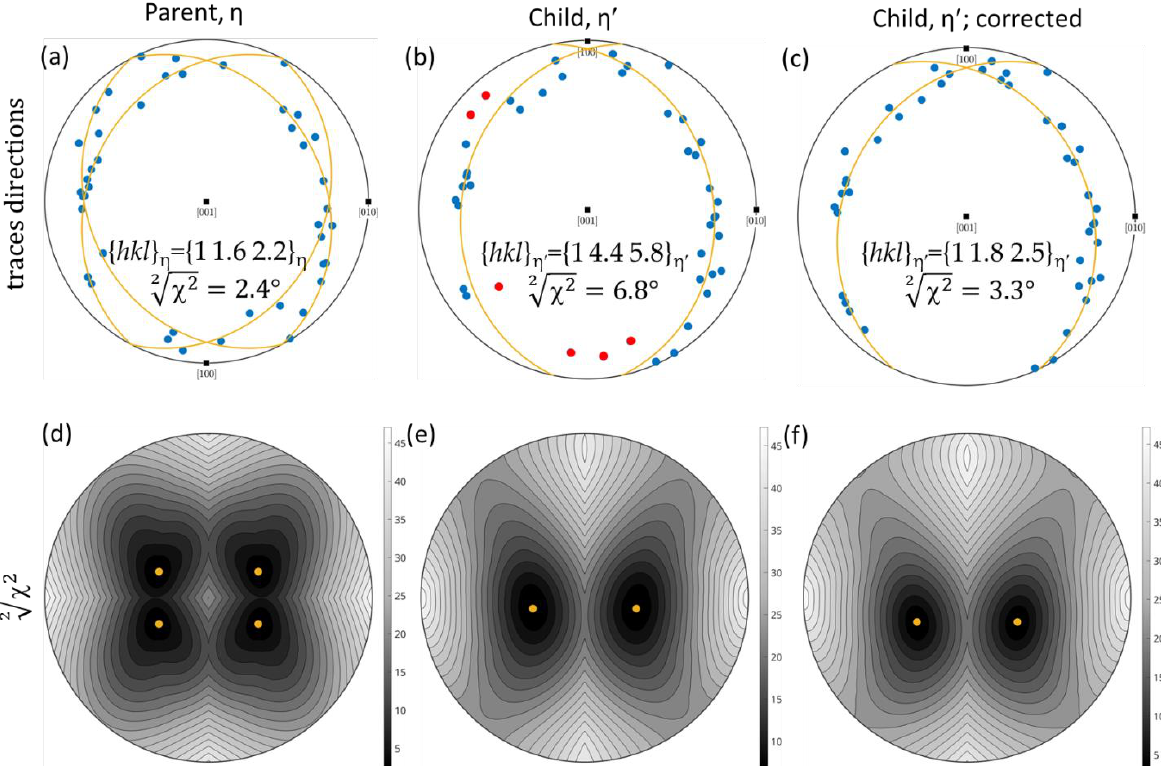
Figure 7. Separate analysis of the directions of the habit plane traces for the parent (P; η ) and child (C; η′ ) depicting stereographic projections illustrating ( a ) the parent traces 𝐫̂ P (𝑛) and ( b ) the child traces 𝐫̂ C (𝑛) , determined via Equation (8a,b). The big circles pertaining to the four equivalent habit planes 𝐡̂ P and two equivalent habit planes 𝐡̂ P are indicated. Traces deviating by more than 5° from the big circles in ( b ) are marked in red. After replacement of those traces by their pseudosym- metric counterparts, all child traces are located on the two big circles ( c ). The { hkl } from 𝜒 2 minimi- zation are given in ( a – c ). Diagrams ( d – f ) illustrate the corresponding direction-dependent value √𝜒 2 2 . The orange points indicate the determined habit plane poles at the minimum related to the symmetry element of the crystal class, i.e., the considered rotational point groups + inversion: mmm (parent) and 12/ m 1 (child). Note the shift of √𝜒 2 2 minima after correction of child traces ( e , f ).